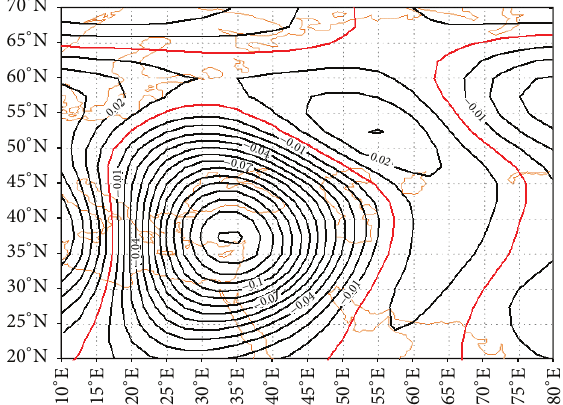
Figure 5: The fourth component of 500 HPa geopotential height level data.